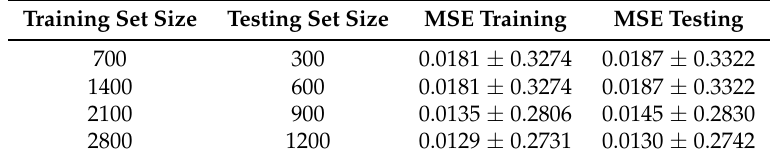
Table 1. Mean square error (MSE) values for the training and testing the MLP (2,25,20,3) network.